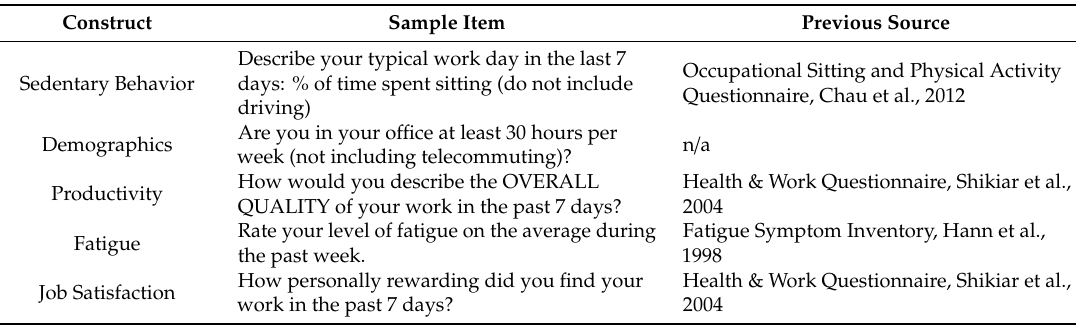
Table 1. Sample survey